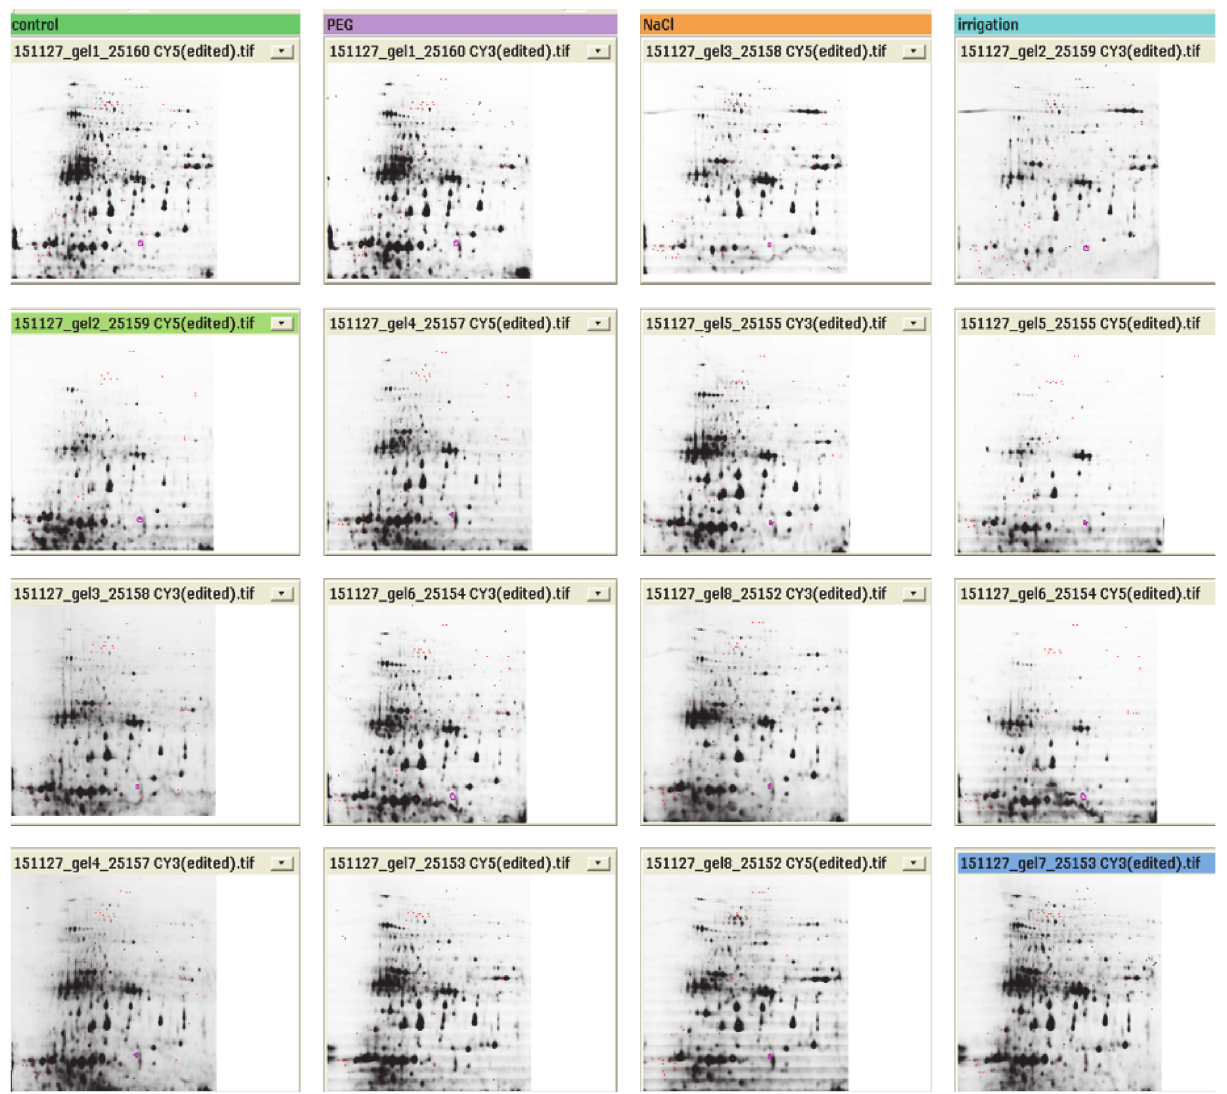
Figure 3: Overview of the fluorescence scans, analytical gels. Color code for analyzed samples: green, control; violet, PEG drought stress; orange, salt stress; blue, no irrigation drought